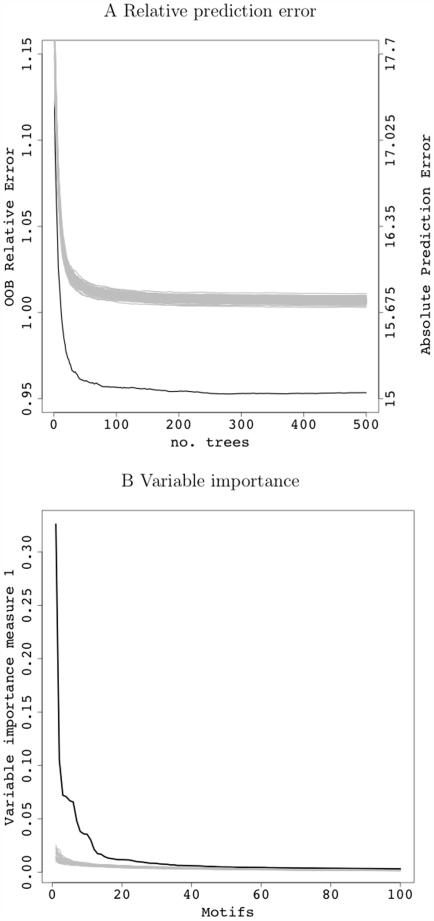
Outputs of (A) relative prediction error (left axis) and absolute prediction error (right axis) and (B) variable importance measures from MRT.Black traces are the real, observed statistics, whereas gray traces are derived from the 100 permuted data. Only top 100 ordered motifs are drawn in B.